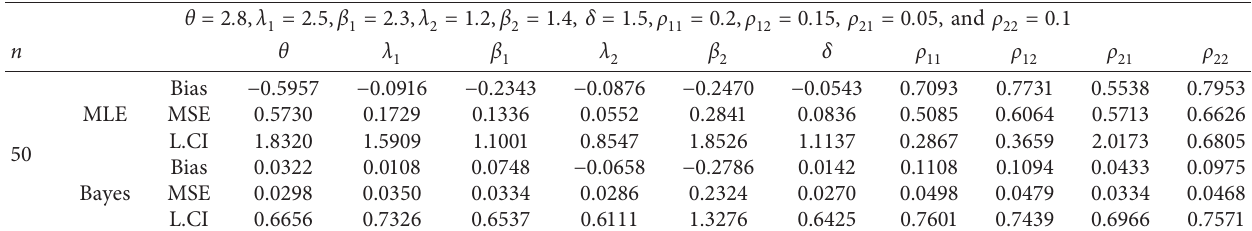
Table 3: MLE and Bayesian estimation with different sample sizes in dependent case (Case